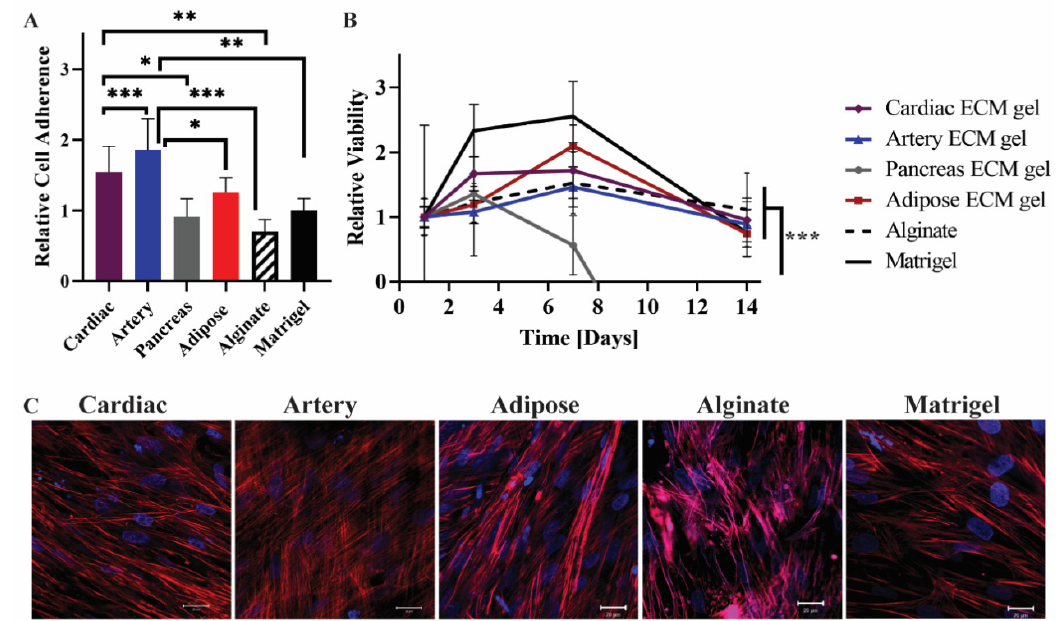
Figure 5. MSCs cultivation on the pECM hydrogels. ( A ) Cell adherence to the pECM hydrogels, and ( B ) viability over 14 days, relative to the viability on each material at day 1 (control). n = 5, * p < 0.05, ** p < 0.01, *** p < 0.0001. ( C ) Fluorescent microscope images of MSCs on the hydrogels 14 days post-seeding. Red: Phalloidin (Actin), Blue: DAPI (DNA). Scale bars, 20 μ m.